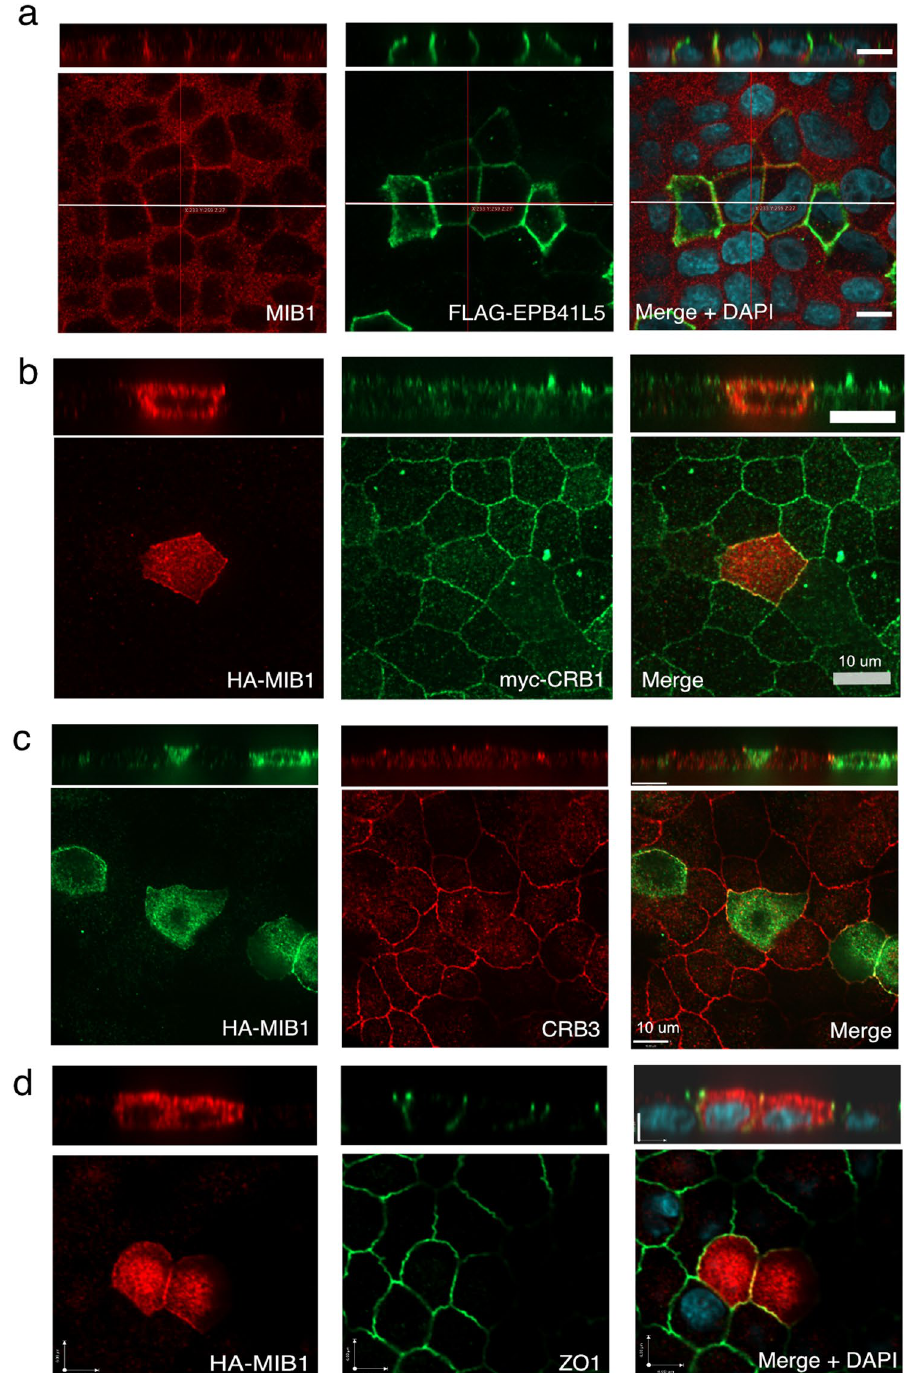
Figure 8. MIB1 co-localizes with EPB41L5 at the lateral membrane and CRB1, CRB3 and ZO1 at tight junctions in polarized MDCK cells. ( a ) Endogenous MIB1 is relocalized from the cytosol/tight junction to the lateral membrane by overexpression of EPB41L5. Polarized MDCK cells were transiently transfected with Flag- EPB41L5 and fixed and stained for endogenous MIB1 (left panel) and Flag (EPB41L5; middle panel). Shown are XY sections captured midway between the basal and apical membranes. XZ sections were captured where the crosshair is positioned (indicated by white line). Images were acquired at 60X magnification on a Quorum spinning disk microscope. Scale bars indicate 10 μ m. ( b ) MIB1 colocalizes with CRB1 at the tight junction region of polarized MDCK cells. MDCK-MycCRB1 cells, transiently transfected with HA-MIB1, were fixed and immunostained with anti-HA (MIB1, left image) and anti-myc (myc-CRB1, middle image). Shown are XY sections taken across the apical region of the cell monolayer and corresponding XZ section. Scale bars indicate 10 μ m. ( c ) MIB1 colocalizes with endogenous CRB3. Polarized MDCK cells, transiently transfected with HA- MIB1, were fixed and immunostained with anti-HA (MIB1) and anti-CRB3. Shown are XY sections taken